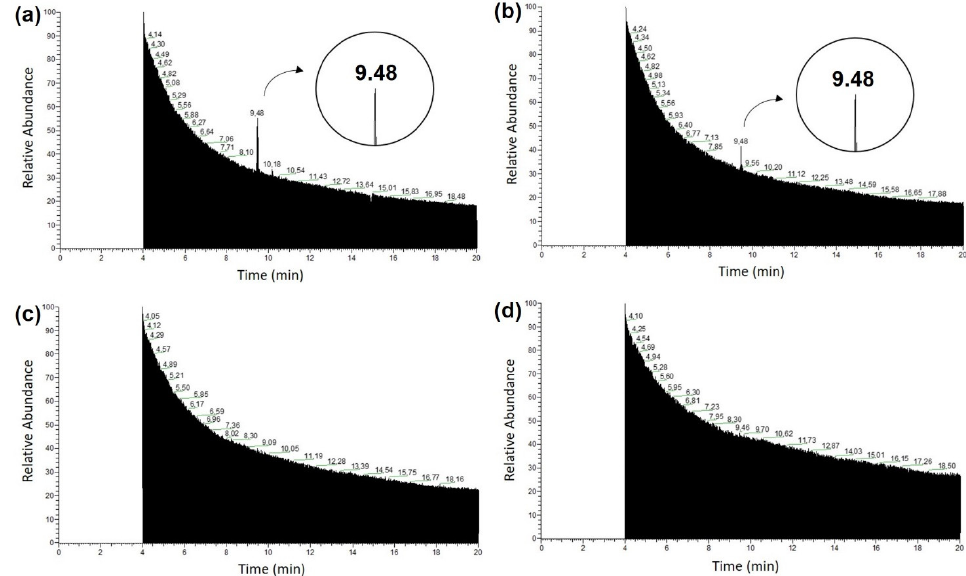
Figure 8. Chromatographic profiles of the functionalization process of MIM– β CP by washes in methanol. ( a ) First wash, ( b ) second wash, ( c ) third wash, and ( d ) fourth wash. The retention time of 9.48 min indicates the removal of the β CP from MIM– β CP.